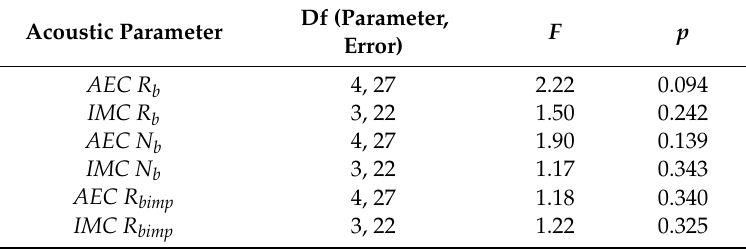
Table 3. One-way analysis of variance of acoustic parameter means across